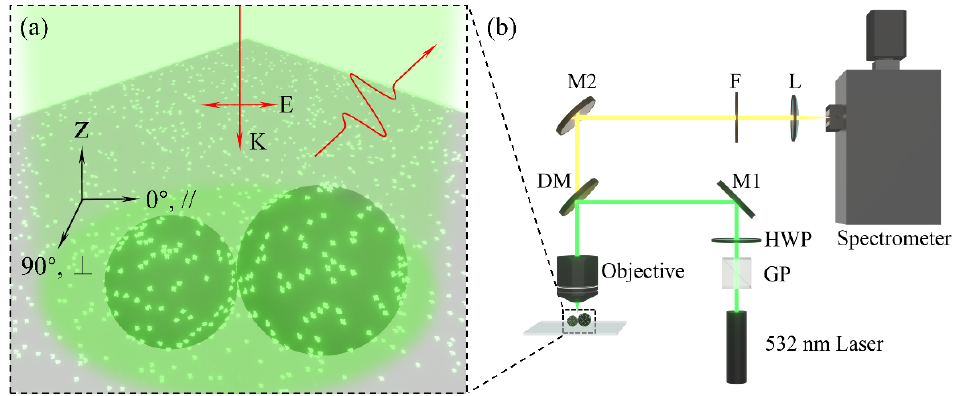
Figure 2. ( a ) Schematic of silicon dimer excited by a continuous-wave laser at 532 nm with controlled polarization. The straight arrows indicate the direction and polarization of the incident laser, and the curved arrow indicates the emission of R6G. ( b ) Schematic of the experimental setup. A homemade scanning microscope was used. GP: Glan prism, HWP: half-wave plate, M: silver mirror, DM: dichroic mirror, F: filter, L: lens.